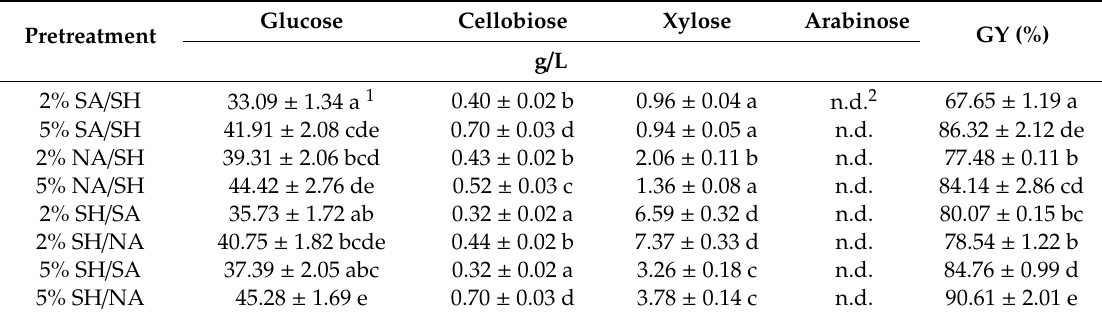
Table 5. The concentration of glucose, xylose, arabinose and cellobiose (g / L) in hydrolysates and glucose yield (%) after hydrolysis of two-stage pretreated